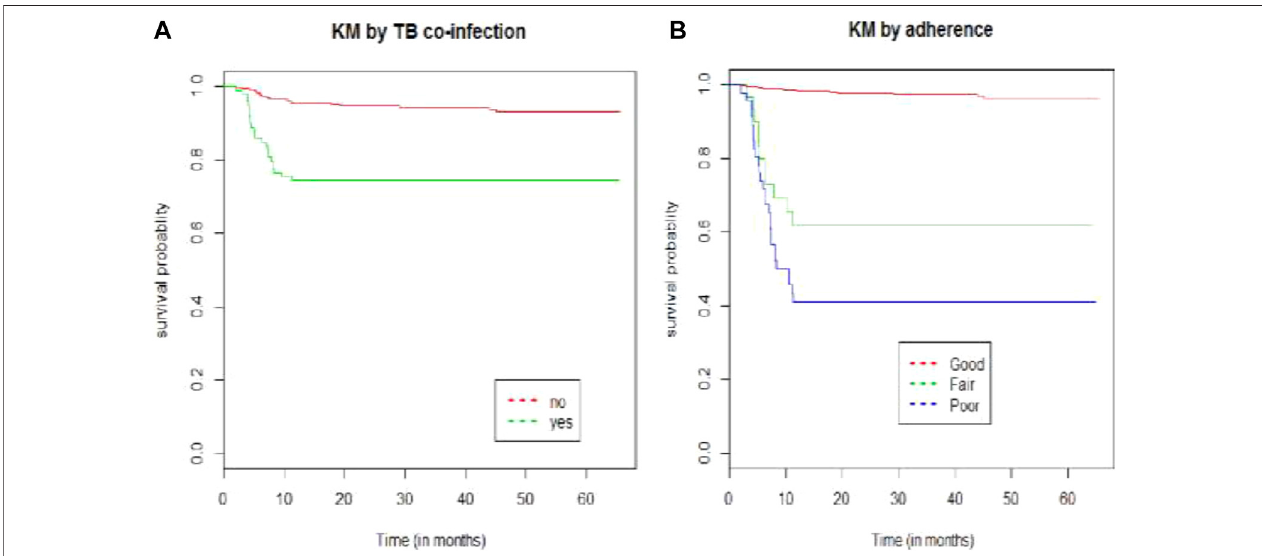
FIGURE 1 | Kaplan – Meier survival curve by (A) TB co-infection and (B) adherence for HIV/AIDS patients on ART at public hospitals in Eastern Ethiopia from 2013 – 2019.